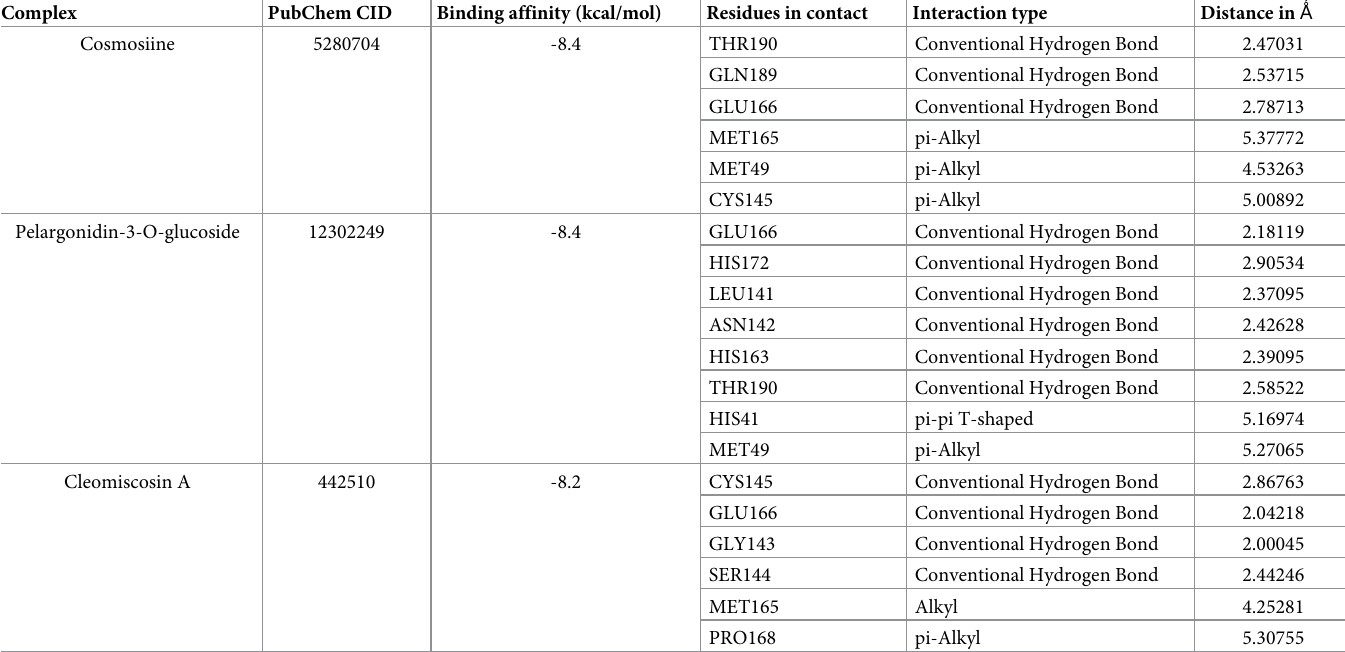
Table 1. Non-bonding interactions between SARS-CoV-2 Mpro and the top 3 phytochemical compounds. Complex